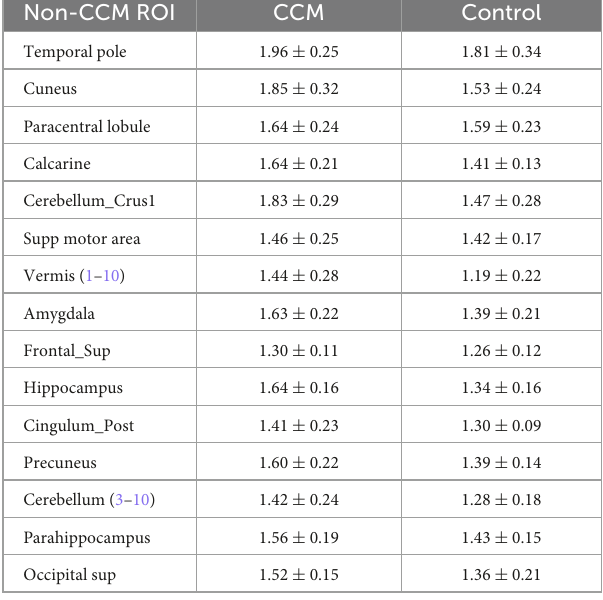
TABLE 2 Regional pseudo-SUVr of flutriciclamide in brain tissue regions for both the CCM and control